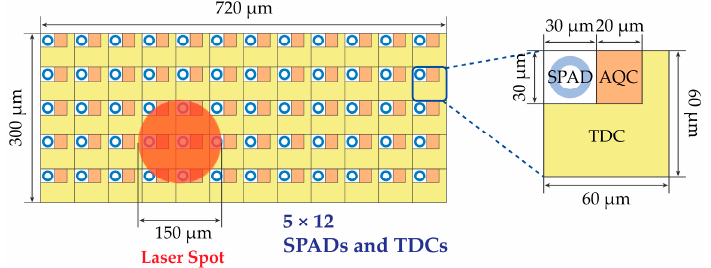
Figure 5. Example of SPAD array with one TDC integrated in each pixel.